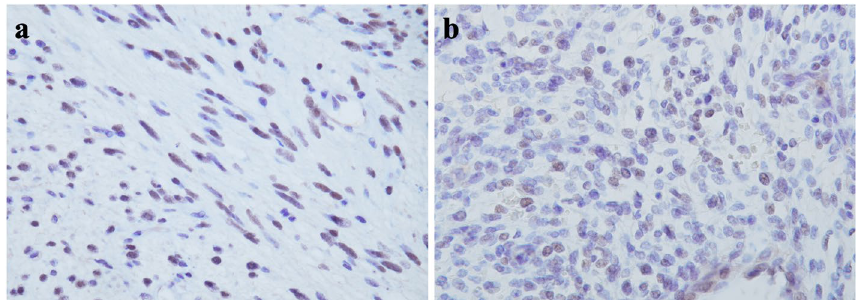
Fig. 4 a BCOR staining of the intra-abdominal tumor. b BCOR staining of uterine adenosarcoma